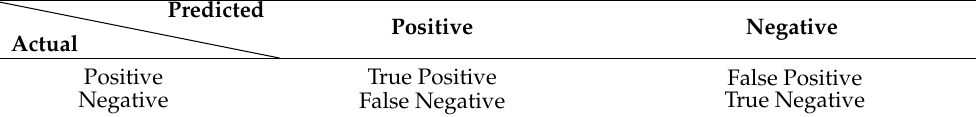
Table 3. Accuracy, Precision and